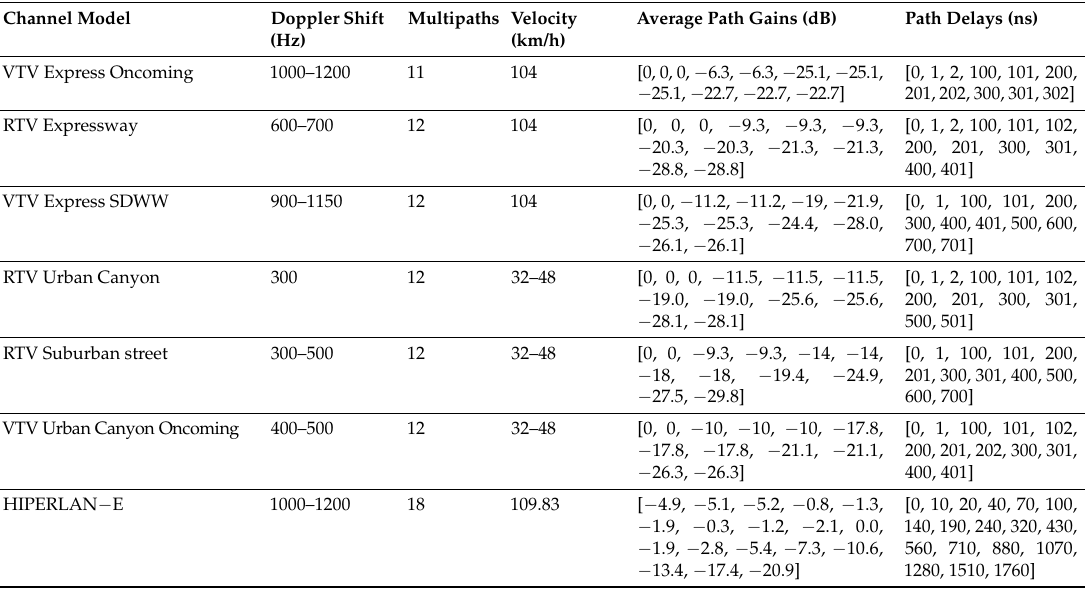
Table 2. Characteristics of the vehicular channel